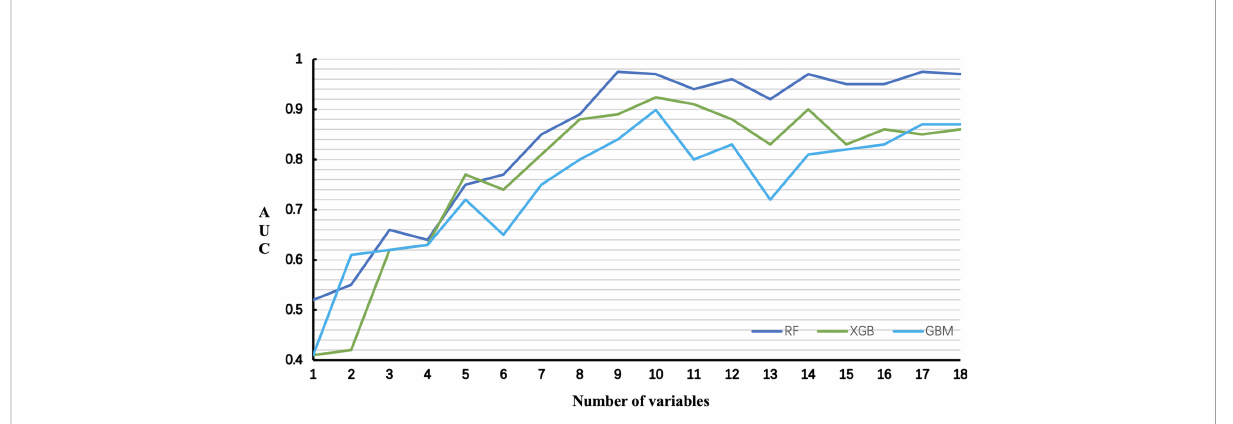
FIGURE 5 Predictive performance of the RF, XGB and GBM model with different numbers of variables. RF Random Forest; XGB Extreme Gradient Boosting; GBM Gradient Boosting